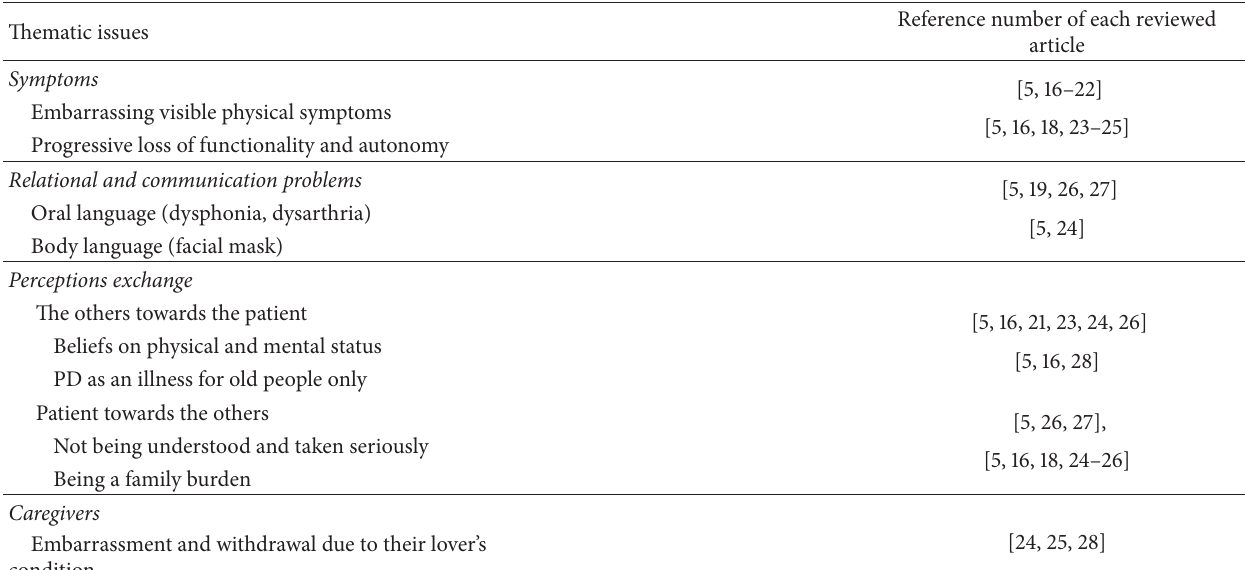
Table 2: Thematic issues related to stigma experience identified in the reviewed